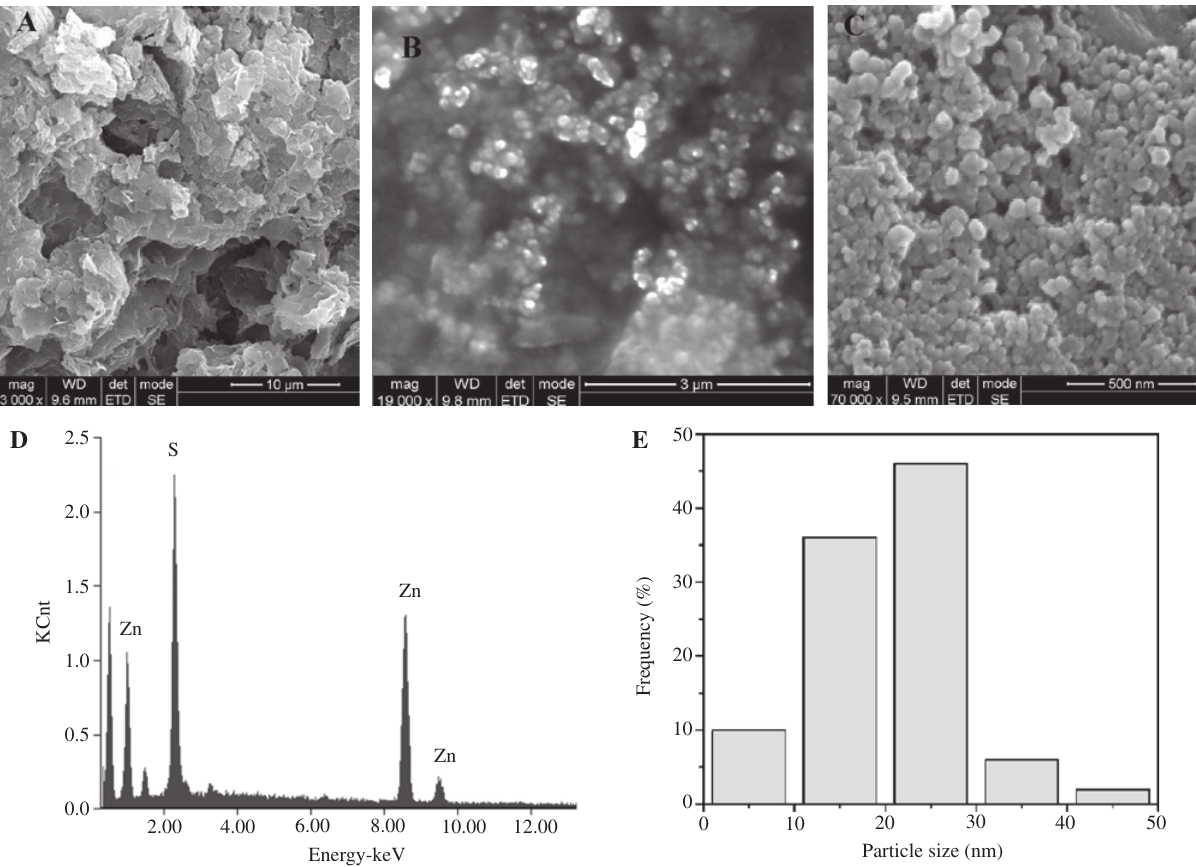
Figure 7: High resolution scanning electron microscopy (HR-SEM) images of zinc sulfide nanoparticles at different magnifications (A–C); (D) EDX analysis of zinc sulfide nanoparticles; particle size distribution graphs